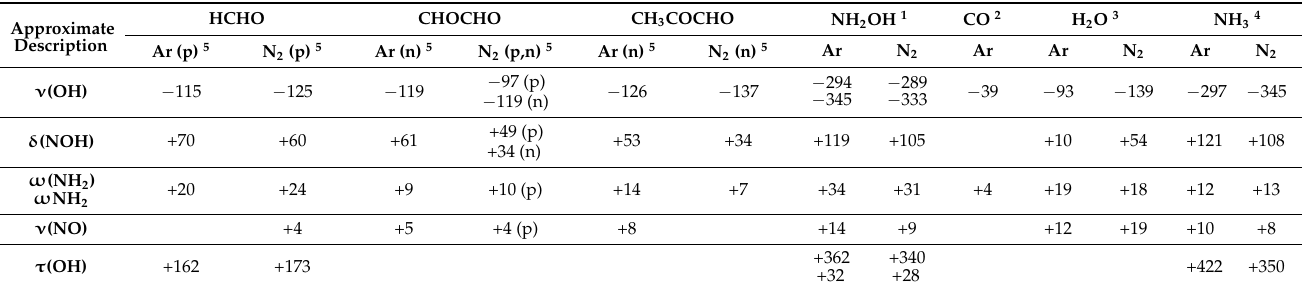
Table 5. The comparison of wavenumber shifts (cm − 1 ) of the vibrational bands of the hydroxylamine moiety in the complexes with formaldehyde, glyoxal, methylglyoxal, hydroxylamine, carbon monoxide and ammonia observed in argon and nitrogen